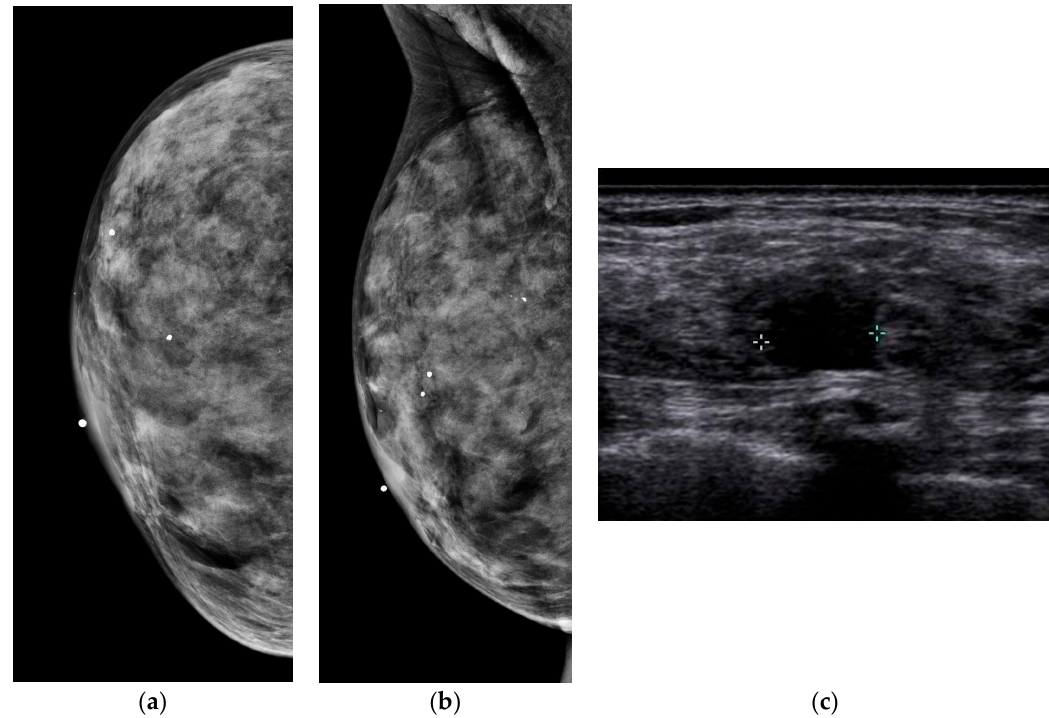
Figure 2. A 43-year-old woman with extremely dense breast tissue. Dense tissue obscures a breast cancer that is easily visible with ultrasound imaging. ( a , b ) Craniocaudal (CC) and mediolateral oblique (MLO) digital mammography. ( c ) Handheld high-resolution ultrasound demonstrates a 1.2 cm irregular mass, denoted by calipers in the image, which was biopsied and proven to be invasive ductal carcinoma.